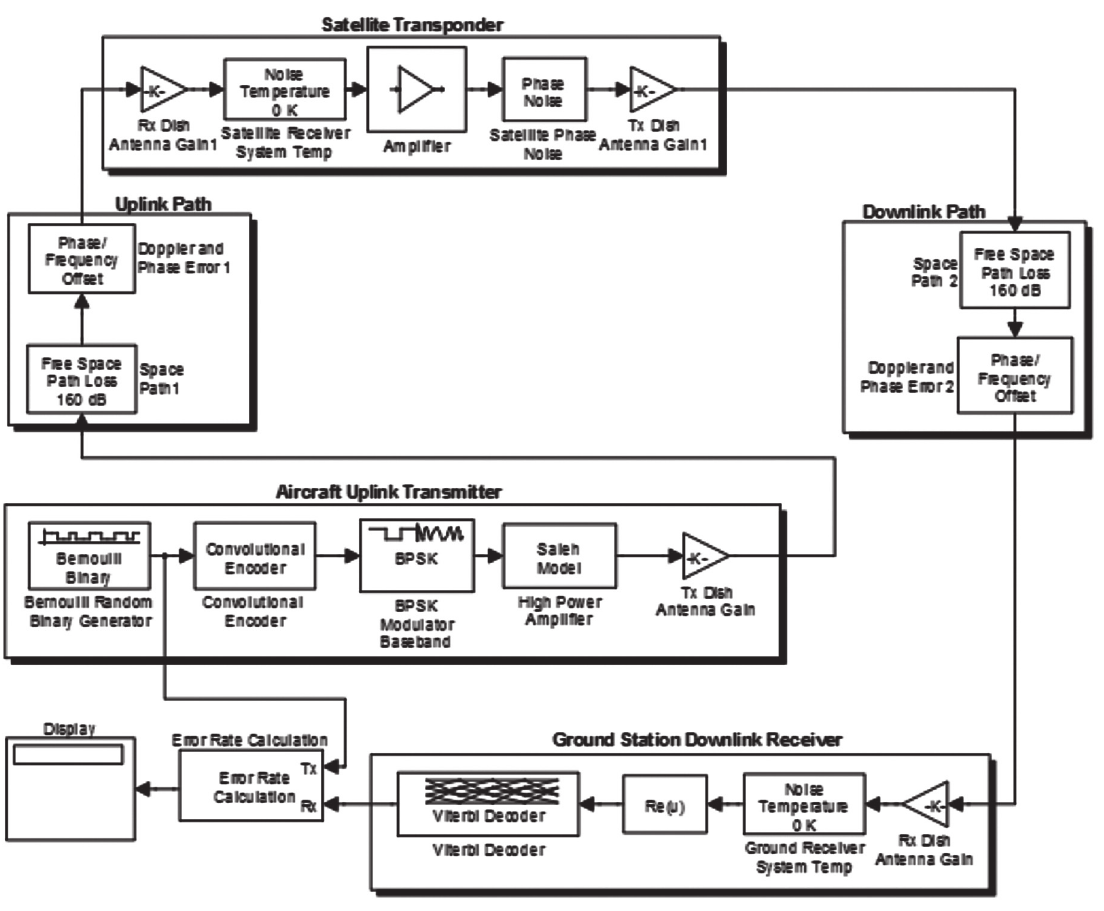
Fig. 1. Aircraft-to-Satellite-to-Ground Station